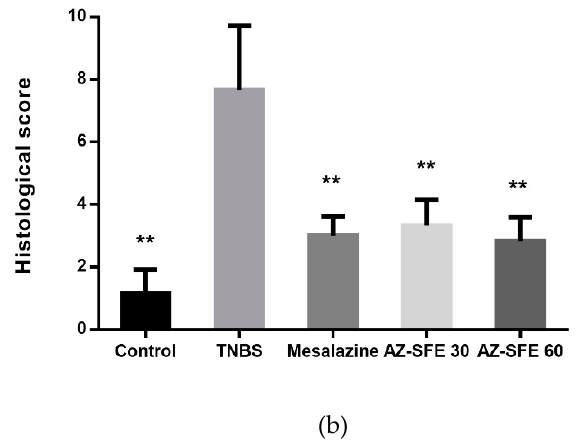
Figure 6. Effects of AZ-SFE (30 and 60 mg/kg) and mesalazine (400 mg/kg) on histological change of TNBS-induced colitis in rats. ( a ) Representative H&E staining slices from colonic tissues, original magnification 100× Ⅰ . Control group; Ⅱ . TNBS group; Ⅲ . Mesalazine group; Ⅳ – Ⅴ . AZ-SFE groups (30 and 60 mg/kg). ( b ) Histological scores. Data are presented as mean ± SD of 6 rats per group. ** p < 0.01 versus TNBS group.